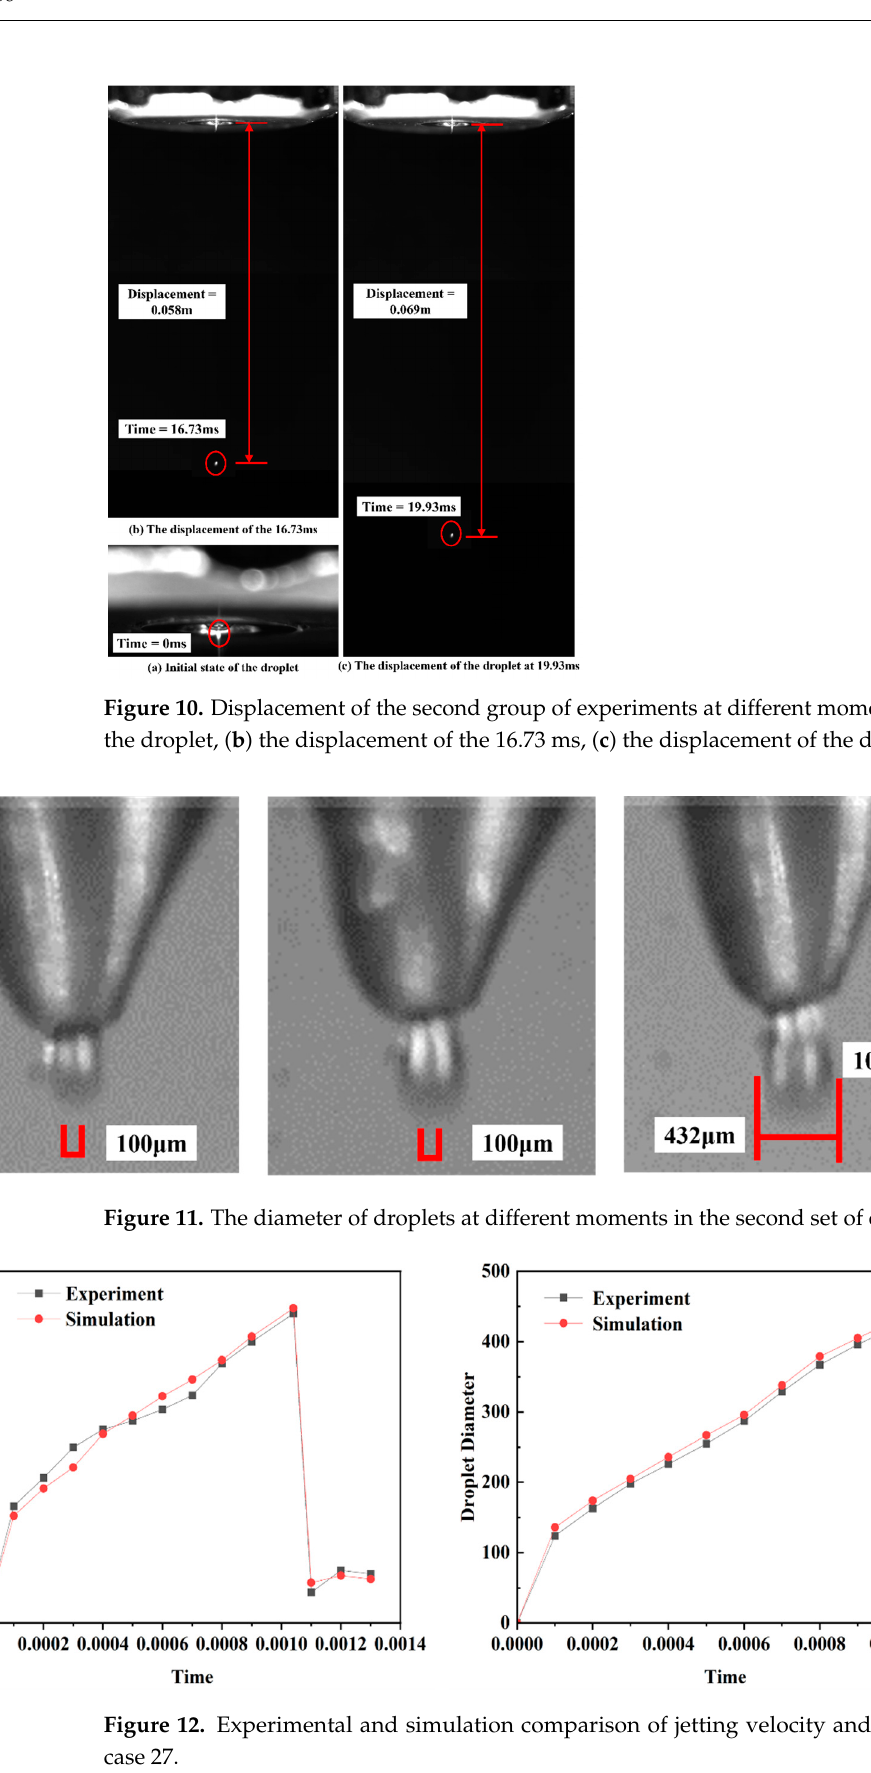
Figure 12. Experimental and simulation comparison of jetting velocity and droplet diameter for case 27. 4. Conclusions This paper presents a method for predicting the performance of piezoelectric injec ‐ tion systems, based on finite element simulations. The obvious advantage of this approach is that it is based on accurate finite element analysis rather than expensive, time ‐ consum ‐ ing, and error ‐ prone collected experimental data. Coupled modeling of the piezoelectric injection process was performed using the ANSYS Fluent software, and quantitative and qualitative validation of literature data and experiments were performed. Two system performance metrics were proposed: jetting velocity and droplet diameter. A finite ele ‐ ment model, with different parameter combinations, was designed, using the Taguchi or ‐ thogonal array method. By comparing the predicted and experimental values of the finite element simulation, the error of the jetting velocity was 3.02% and the error of the droplet diameter was 2.20%, indicating that the method proposed in this paper can predict the system performance.